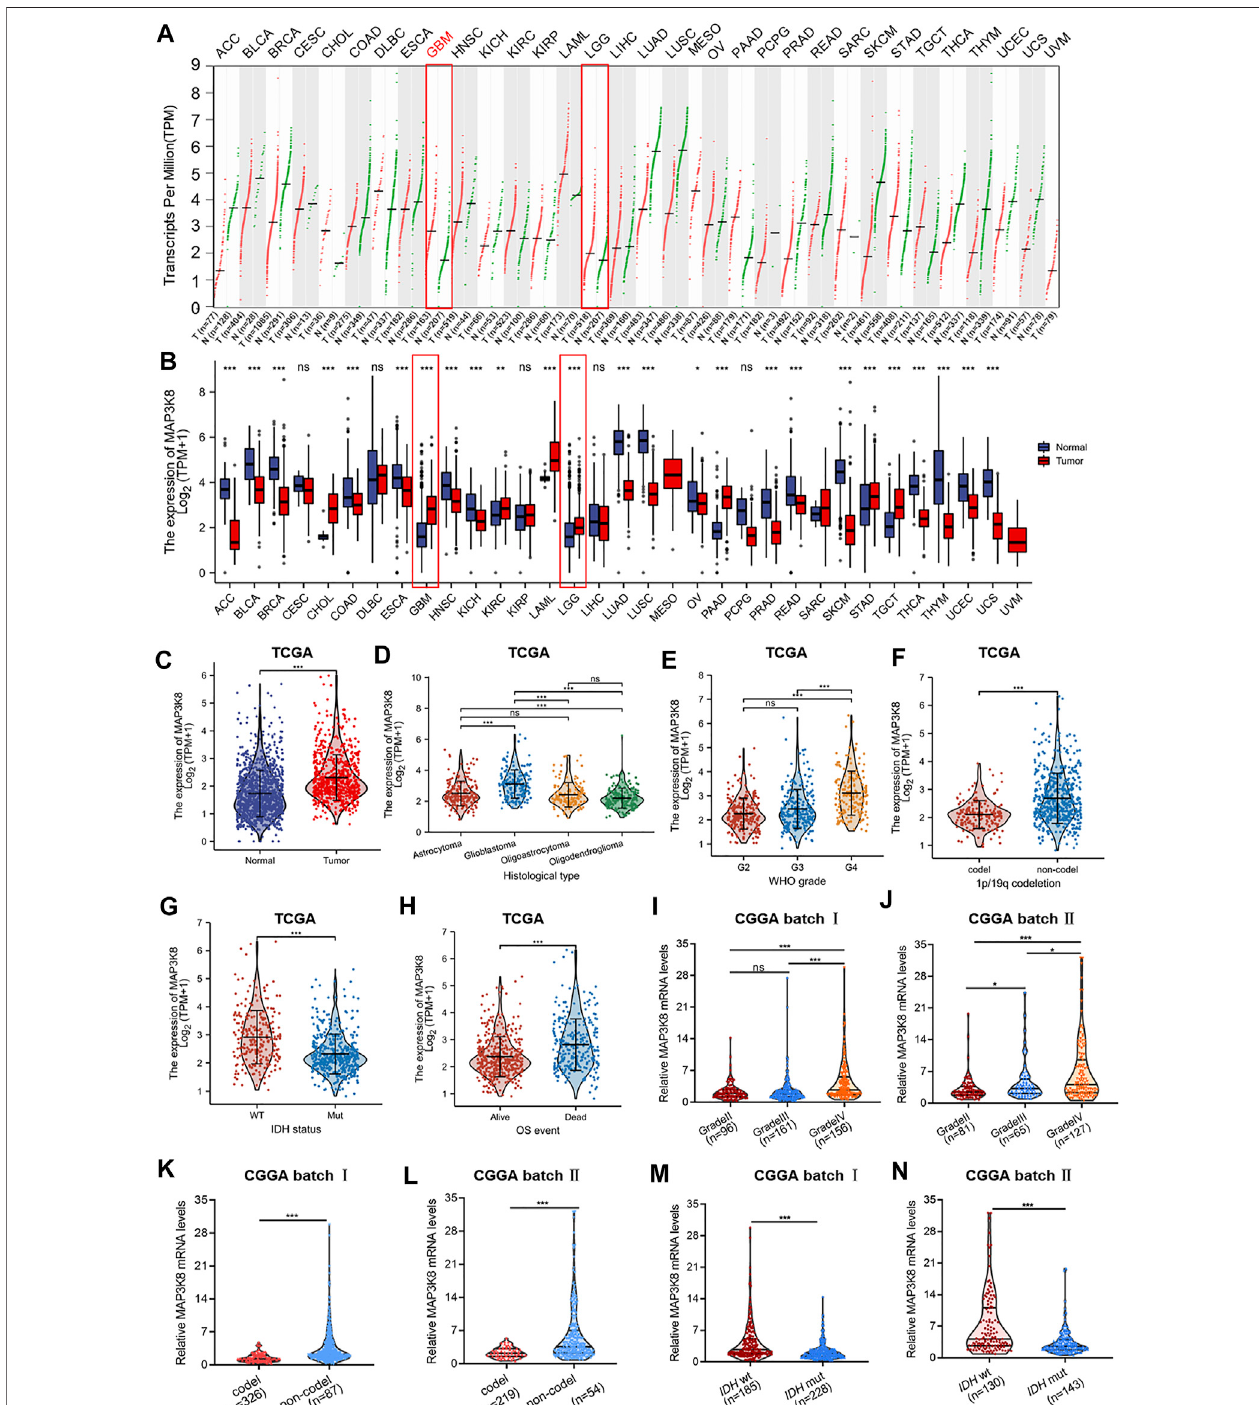
FIGURE 1 | MAP3K8 was aberrantly overexpressed in glioma from The Cancer Genome Atlas (TCGA) and Chinese Glioma Genome Atlas (CGGA) databases. (A) Dotplotshowingthegeneexpressionpro fi lesacrossalltumorsamplesandpairednormaltissuesfromtheGeneExpressionPro fi lingInteractiveAnalysiswebserver. (B) The mRNA level of MAP3K8 analyzed across all tumor samples and paired normal tissues from TCGA database ( n (cid:1) 703) and Genotype-Tissue Expression (GTEx) database ( n (cid:1) 1,152). (C) The mRNA level of MAP3K8 analyzed from the CGGA database. (D – H ) MAP3K8 expression in different histological types (D) , WHO grades ( E ), 1p/19q status (F) , and isocitrate dehydrogenase ( IDH ) genotypes (G) and the overall survival event (H) of glioma patients from TCGA. (I , J) MAP3K8 expressionanalyzedindifferentWHOgradesfromCGGAbatchI (I) andbatchII (J) . (K , L) MAP3K8expressionanalyzedindifferent1p/19qstatusfromCGGAbatchI (K) and batch II (L) . (M , N) MAP3K8 expression analyzed in different IDH genotypes from CGGA batch I (M) and batch II (N) .